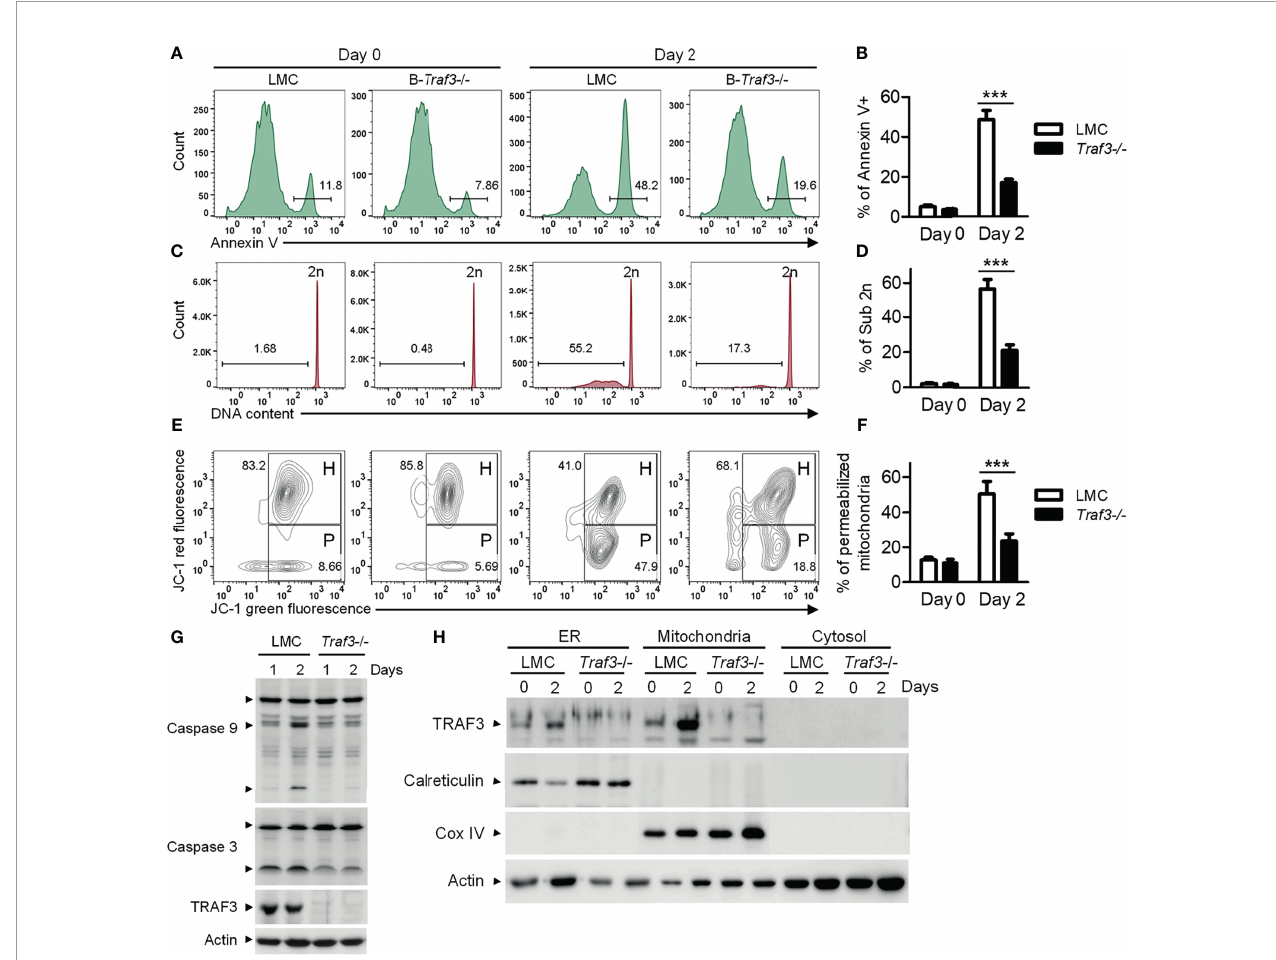
FIGURE 1 | TRAF3 promoted the mitochondria-dependent intrinsic apoptotic pathway and was mainly localized at mitochondria in resting B cells. Splenic B cells were puri fi ed from gender-matched, young adult (8-12-week-old) naïve LMC or B- Traf3 -/- mice. Puri fi ed cells were analyzed directly (Day 0) or at day 2 after ex vivo culture in mouse B cell medium. (A) Representative FACS pro fi les of annexin V staining. Gated populations indicate the annexin V+ apoptotic cells. (B) Graphical results of the percentage of annexin V+ apoptotic cells. (C) Representative FACS pro fi les of cell cycle distribution analyzed by PI staining. Gated populations indicate apoptotic cells with DNA fragmentation (DNA content < 2n). (D) Graphical results of the percentage of apoptotic cells with DNA fragmentation. (E) Representative FACS pro fi les of mitochondrial membrane permeabilization measured by MitoProbe JC-1 staining. Gated populations in H show cells with healthy mitochondria and gated populations in P indicate cells with permeabilized mitochondria. (F) Graphical results of the percentage of cells with permeabilized mitochondria. (G) Cleavage of caspase 9 and caspase 3. Total cellular proteins were prepared at day 1 or day 2 after culture and immunoblotted for caspase 9 and caspase 3, followed by TRAF3 and actin. (H) Cytoplasmic TRAF3 proteins were mainly localized at mitochondria in resting B cells. ER, mitochondrial and S100 (cytosolic) proteins were biochemically fractionated and analyzed by immunoblotting. Proteins in each fraction were immunoblotted for TRAF3, calreticulin (an ER protein), COX IV (a mitochondrial protein) and actin. Immunoblots shown are representative of 3 experiments. Graphs shown in (B, D, F) are the mean ± SD (n=6/group, including 3 female and 3 male samples). *** p < 0.001 by t